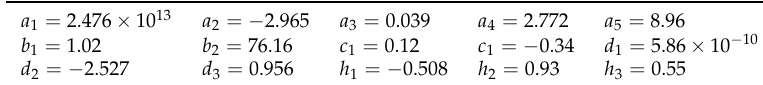
Table 9. Empirical model